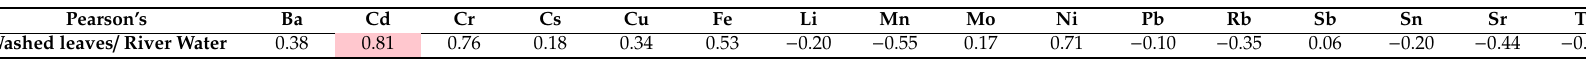
Table 3. Pearson’s correlation coe ffi cients calculated between river water and washed leaves element concentrations: Mean monthly concentrations at each site were included in the elaboration (N = 30). Positive linear correlations (Pearson’s coe ffi cient > 0.8) between the two variables are reported in